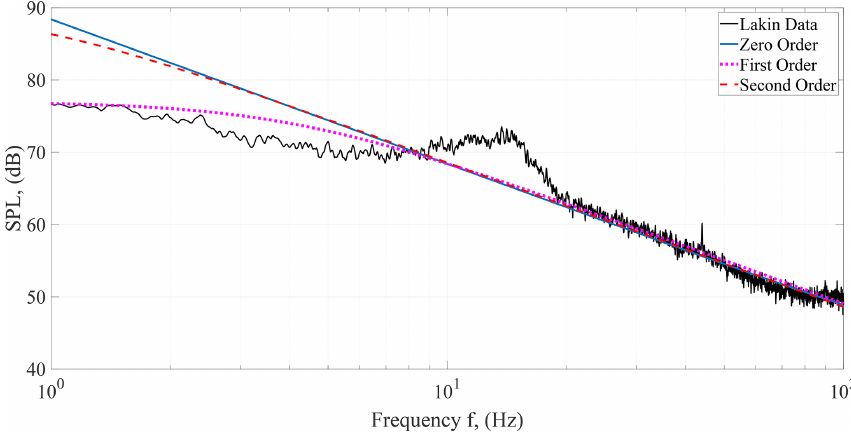
Figure 14. First-stage model fit to Lakin, KS, tornado infrasound/low-sonic measurements.